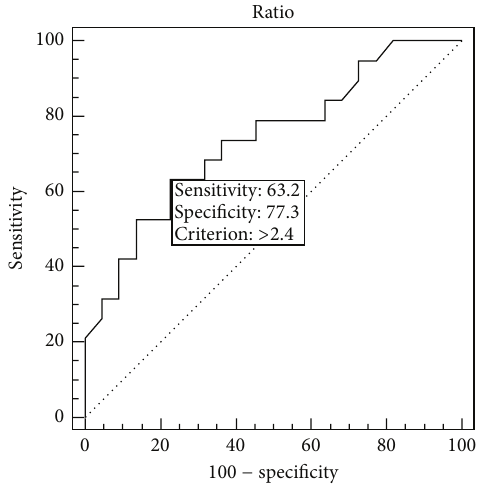
Figure1:ROCcurveofN/Lratiotodiscriminaterecurrenceinoptic neuritis